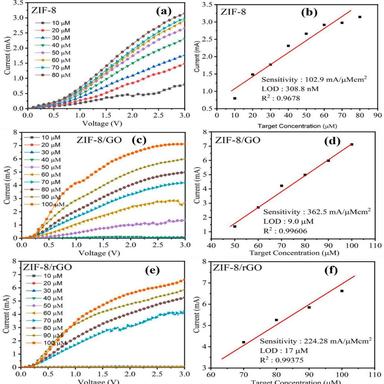
Current-Voltage (I-V) responses towards different concentrations of Cu2+ ions and corresponding calibration plots for fabricated (a, b) ZIF-8, (c, d) ZIF-8/GO, and (e, f) ZIF-8/rGO composites-based Cu2+ ions sensors.